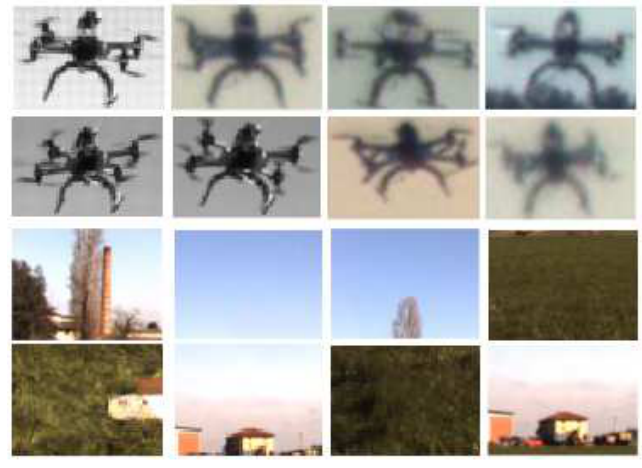
Figure 14. Examples of the images used in the training set for vision-based UAV detection.